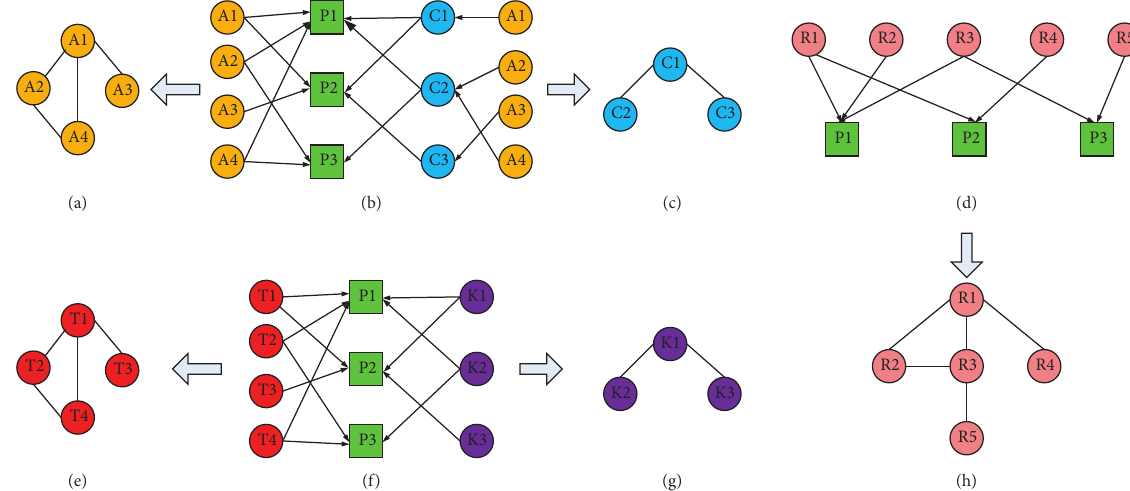
Figure 1: Pictorial view of network construction. Note: A is the abbreviation of author, C is country, P is paper, R is reference, T is term, and K is keyword. The thickness of a line denotes the weight of the edge. The color of a circle represents the node type. (a) Author- collaboration network. (b) Author-article-country relationship. (c) Country-collaboration network. (d) Reference-article relationship. (e) Terms co-occurrence network. (f) Terms-article-keywords relationship. (g) K.eywords cooccurrence network. (h) Cocitation